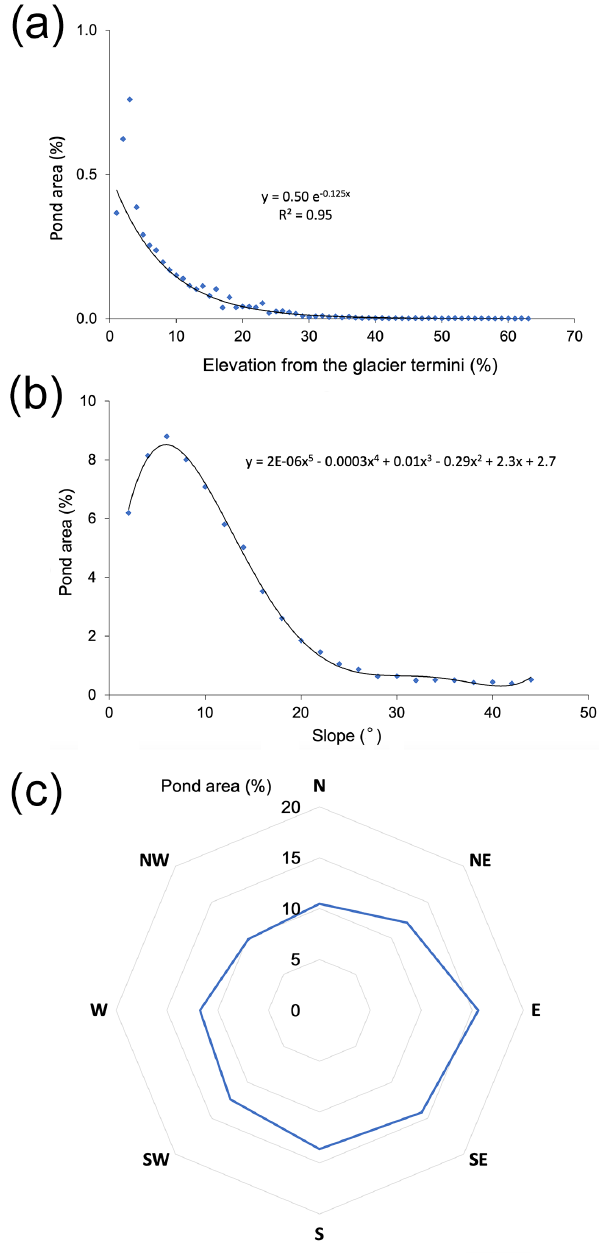
Figure 12. Plots of supraglacial pond coverage summarized over (a) elevation bands expressed as percent above terminus, (b) slope expressed as 2 ◦ bins and (c) glacier aspect expressed as 45 ◦ bins.